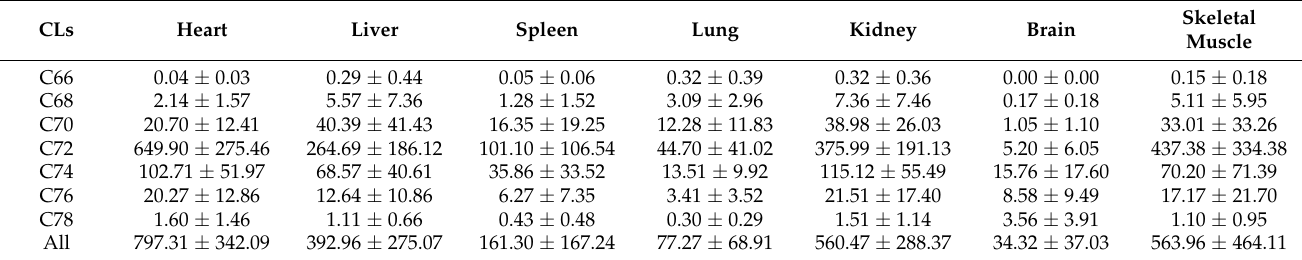
Table 1. The relative content of C66 group, C68 group, C70 group, C72 group, C74 group, C76 group and C78 group in seven tissues.